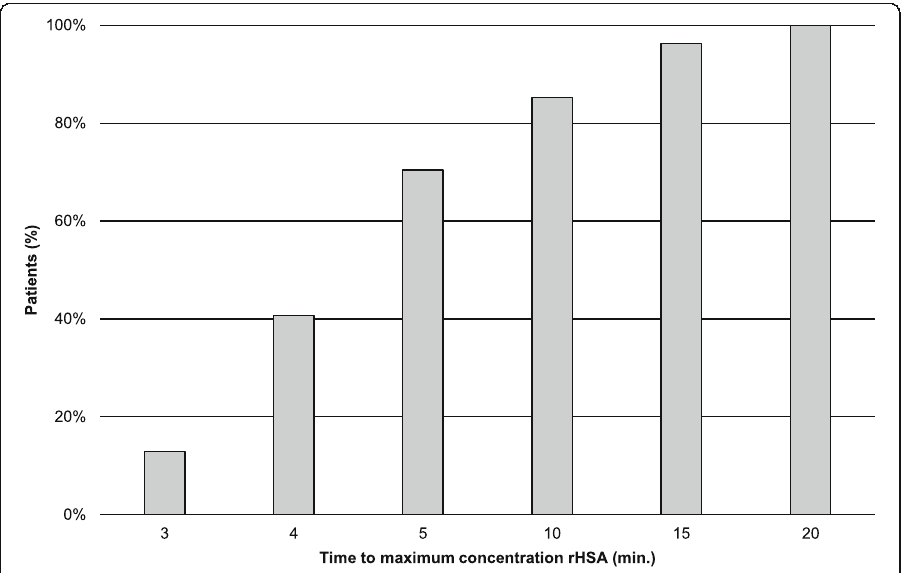
Fig. 2 Percentage of participants reaching serum maximum rHSA activity after administration of rHSA (T max )